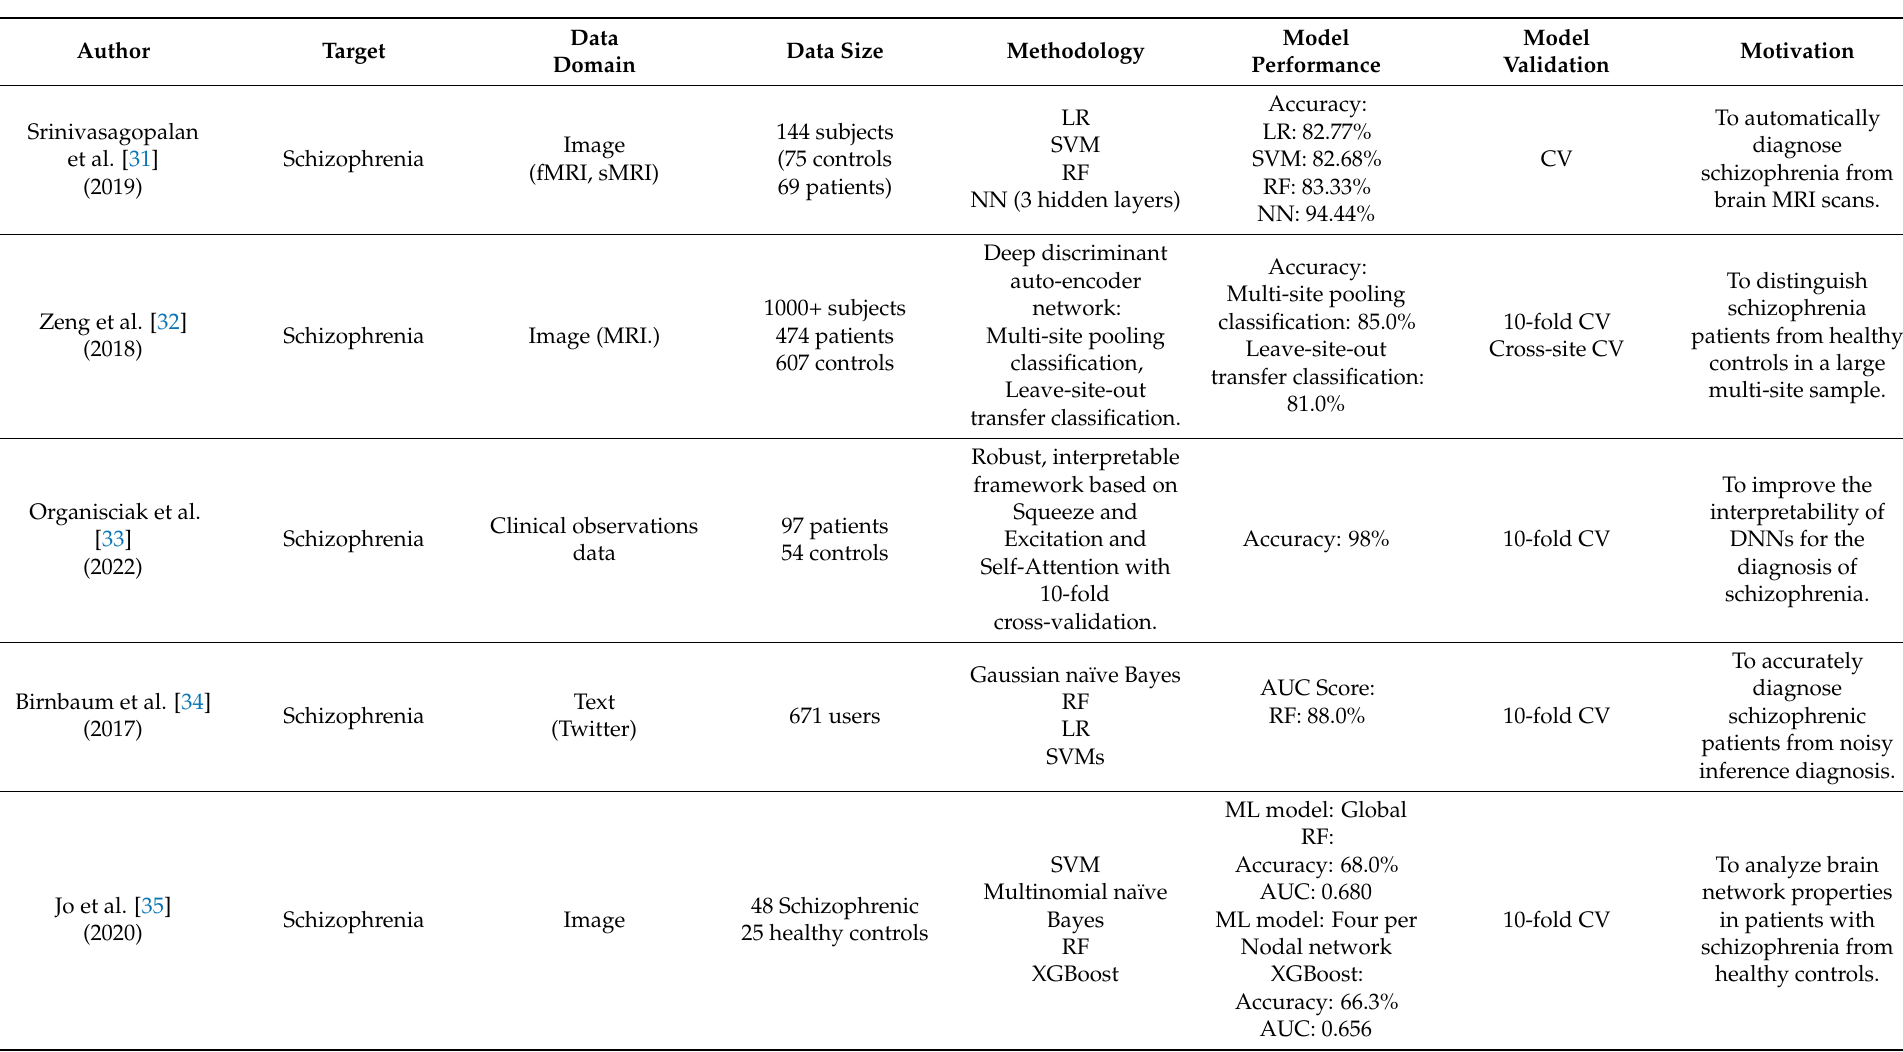
Table 3. Summary of papers included in this